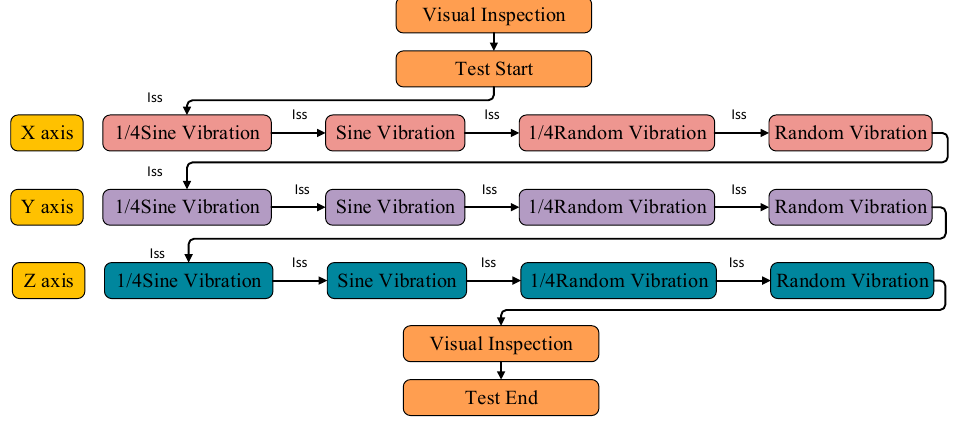
Figure 16. Vibration testing procedure flow diagram.